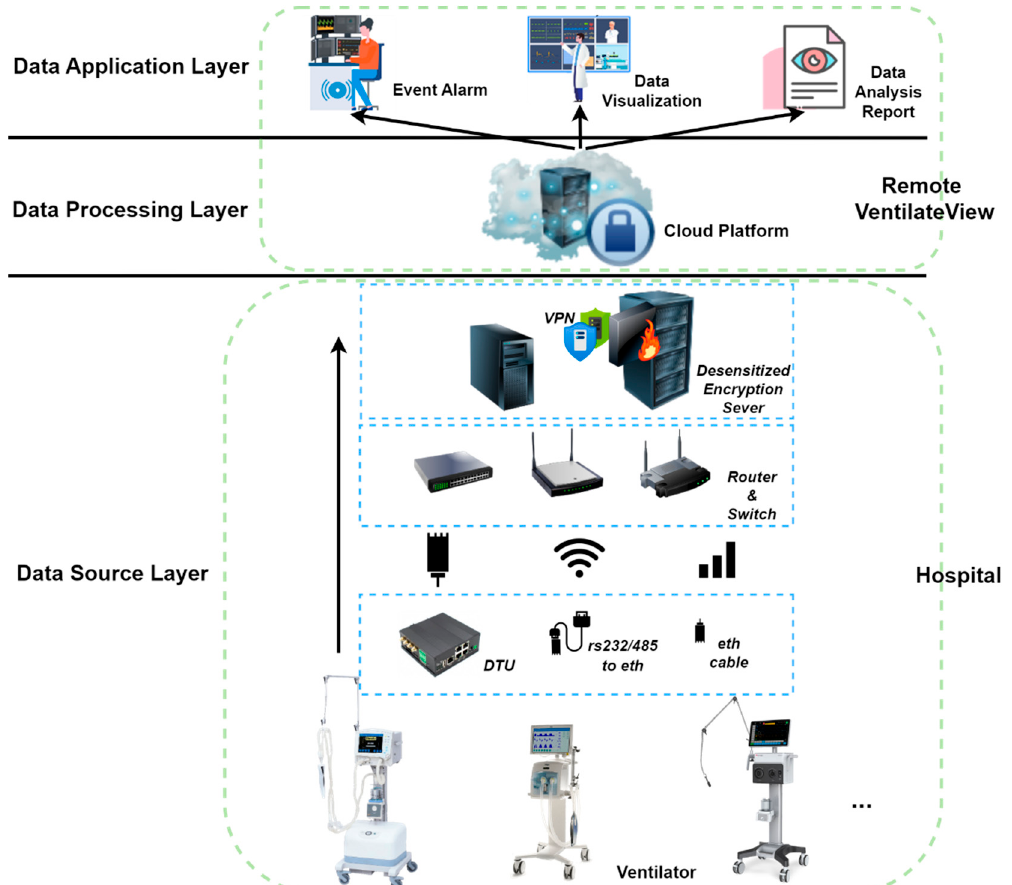
Figure 2. Remote-VentilateView network topology.